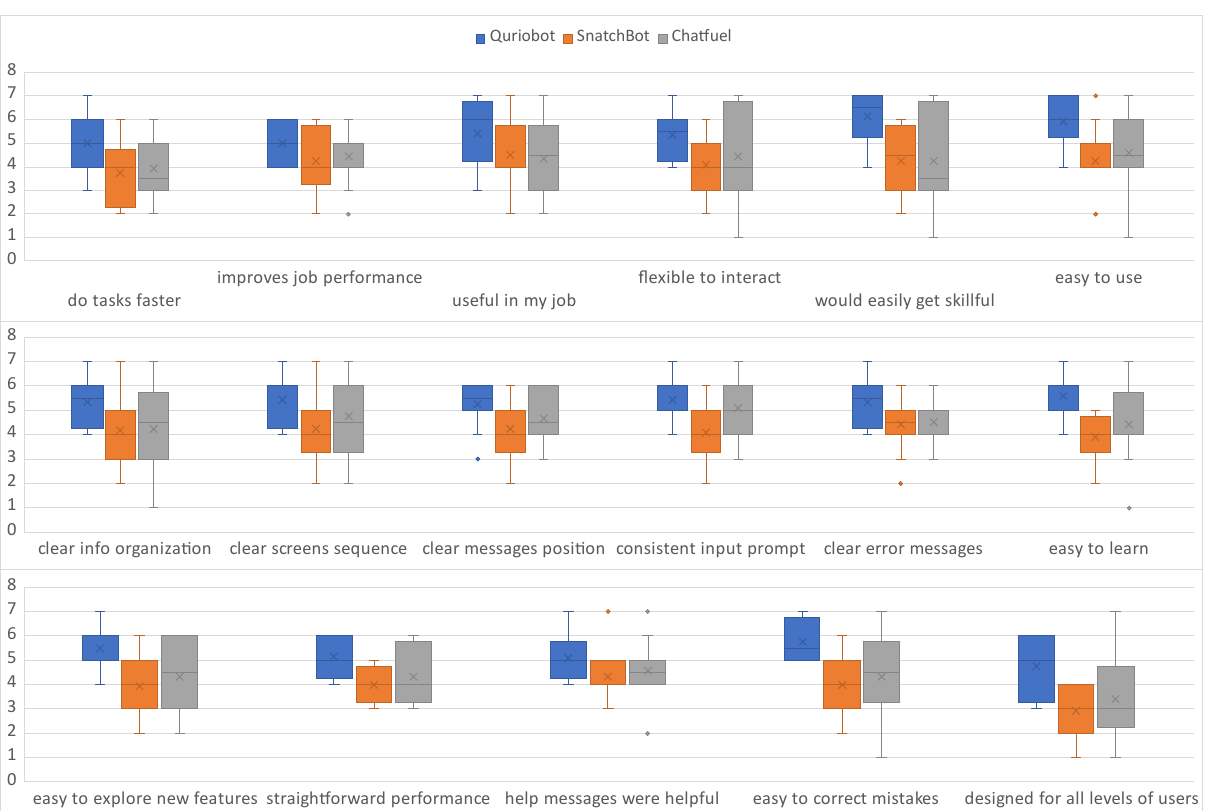
Figure 5. Box Plot of evaluation results from the two-part chatbot programming workshop.